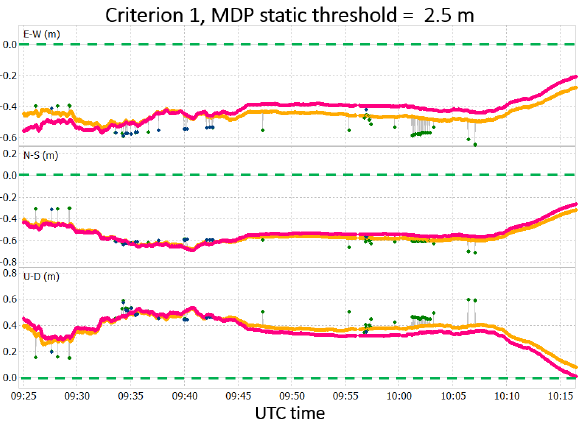
Figure 10. Results obtained after MDP algorithm application using criterion 1 and static MDP threshold equal to 2.5